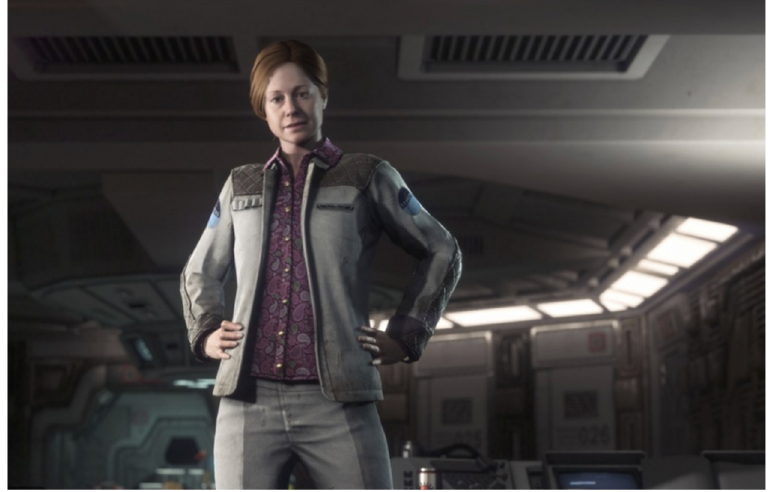
Figure 4. Potential mother figure, Captain Diane Verlaine, of the transport vessel Torrens